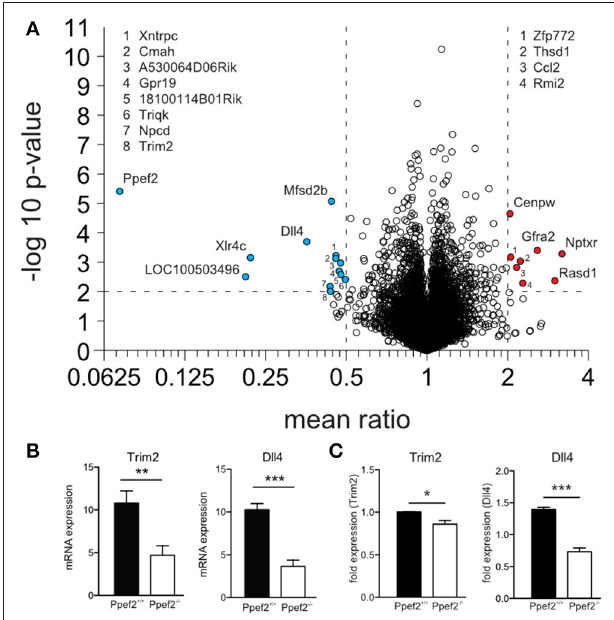
FIGURE 5 | RNA-sequencing reveals changes in RNA-expression of Ppef2 − / − CD8 + cDC1. (A) CD8 + DCs were purified by flow cytometry from cell suspensions of 3 pooled spleens as live MHCII + CD11c + CD11b − CD8 + cells to purity of > 95%. 15 spleens from Ppef2 + / + or Ppef2 − / − mice were used to generate 5 samples each for RNA-sequencing. Shown is the volcano plot analysis of sorted CD8 + DCs. Fold change of − 2 (a, blue) and + 2 (a, red), and a p -value ≤ 0.01 were chosen as cut-off. Ppef2, protein phosphatase EF-hands 2; LOC100503496, uncharacterized transcript LOC100503496; Xlr4c, X-linked lymphocyte-regulated 4C; Dll4, delta-like ligand 4; Trim2, tripartite motif-containing 2; Npcd, neuronal pentraxin chromo domain; Mfsd2b, major facilitator superfamily domain containing 2B; Cmah, cytidine monophospho-N-acetylneuraminic acid hydroxylase; Xntrpc, Xndc1-transient receptor potential cation channel, subfamily C, member 2; A530064D06Rik, Riken cDNA A530064D06 gene; 1810014B01Rik, Riten cDNA 1810014B01 gene; Triqk, triple QxxK/R motif containing; Nptxr, neuronal pentraxin receptor; Rasd1, RAS, dexamethasone-induced 1; Gfra2, glial cell line derived neurotrophic factor family receptor alpha 2; Rmi2, RMI2, RecQ mediated genome instability 2; Thsd1, thrombospondin, type I, domain 1; Ccl2, chemokine (C-C motif) ligand 2; Zfp772, zinc finger protein 772; Cenpw, centromere protein W. (B) Boxplots represent normalized expression with 0,1 quantile, 0.9 quantile and all single points (each group n = 5) ** p < 0.01, *** p < 0.001 for Trim2 and Dll4 in Ppef2 + / + and Ppef2 − / − cells. (C) qPCR of Trim2 and Dll4 in sorted spleen CD8 + DCs. Spleen DCs were sorted as CD11c + MHCII + CD8 + CD11b − in three independent experiments and three Ppef2 + / + or Ppef2 − / − mice were pooled for every sort. Statistical analysis was performed using Student’s t -test, with * p < 0.05; *** p <